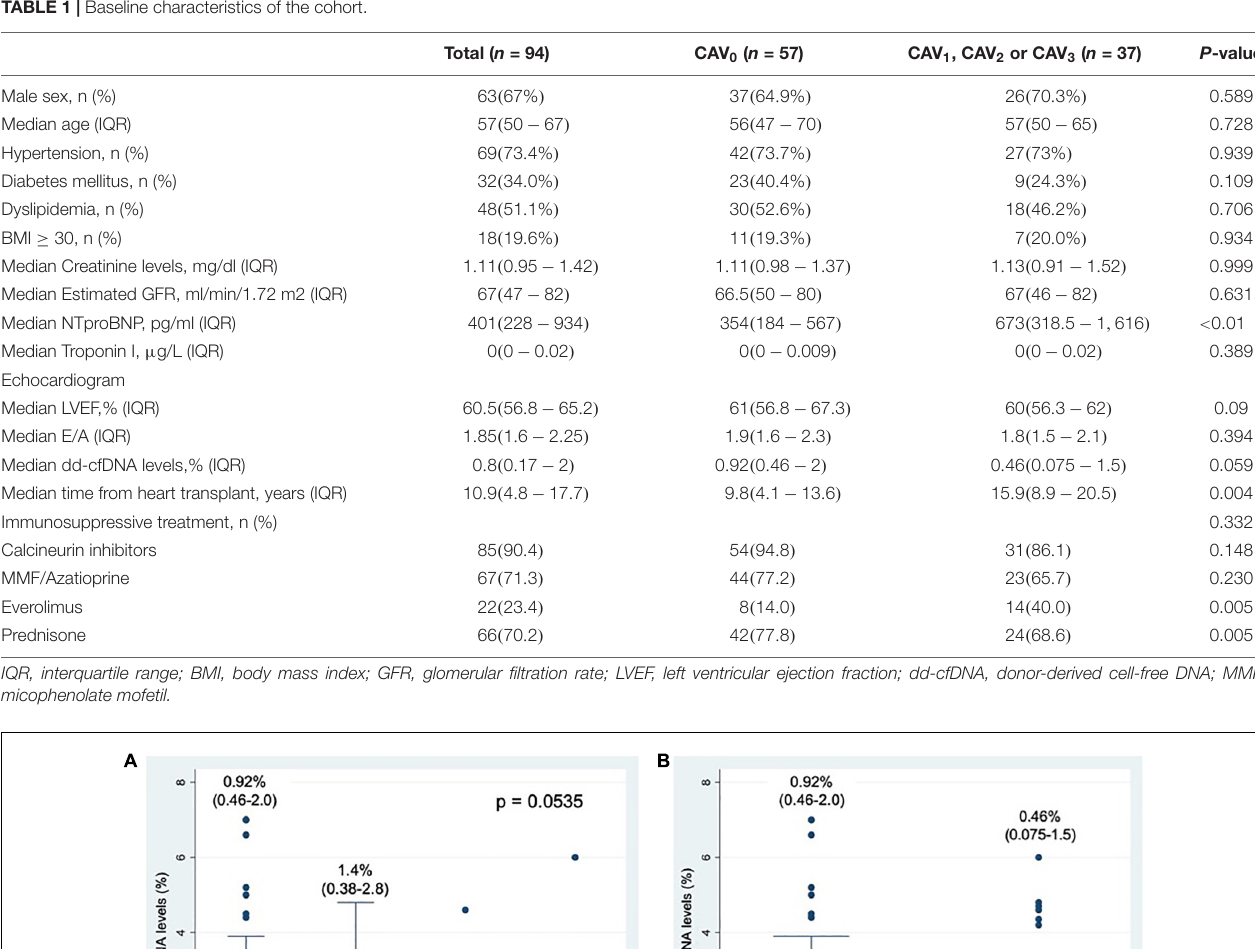
TABLE 1 | Baseline characteristics of the cohort.